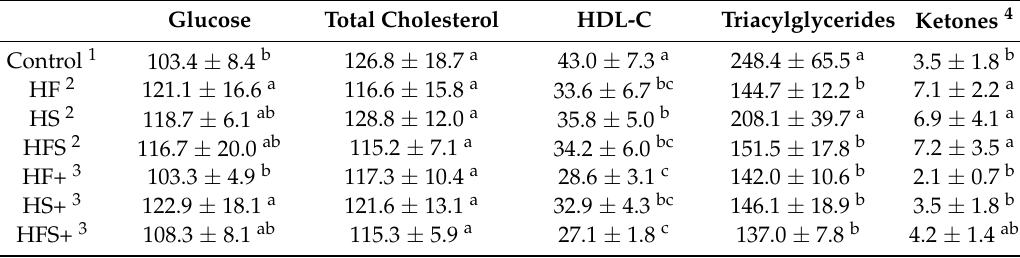
Table 3. Plasma/urine biochemistry from rats fed with experimental